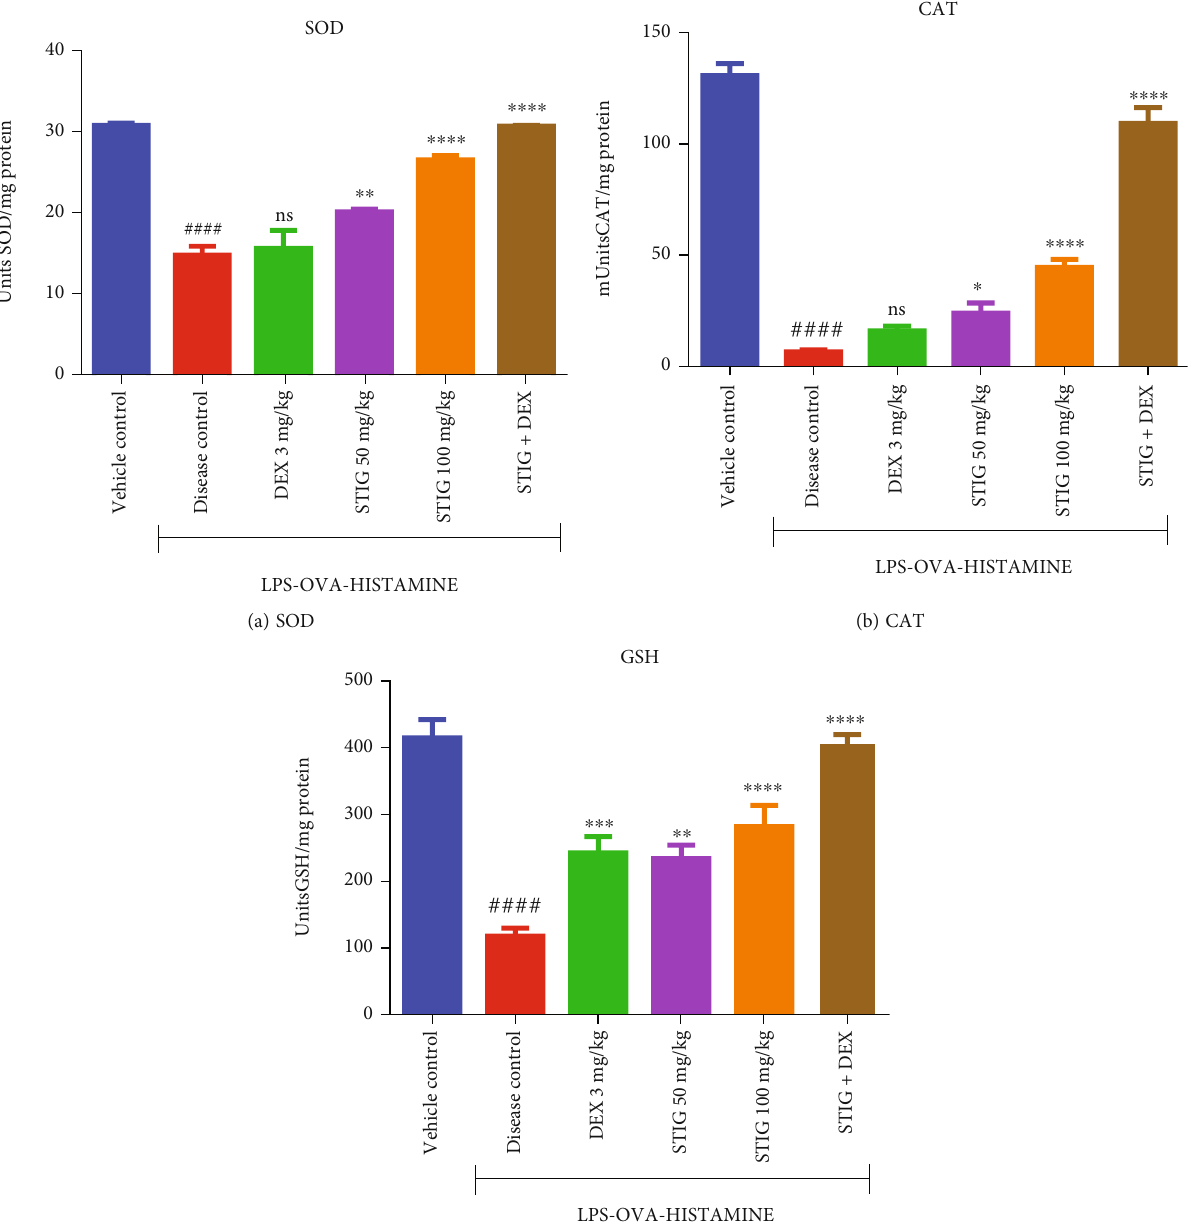
Figure 4: E ff ect of STIG and STIG+DEX on SOD, CAT, and GSH levels. Data is expressed as mean ± SEM . #### p < 0 : 0001 compared to the vehicle control group; ∗∗∗∗ p < 0 : 0001 , ∗∗∗ p < 0 : 001 ∗∗ p < 0 : 01 , ∗ p < 0 : 05 , and ns (not signi fi cant) as compared to the disease control group using one-way ANOVA followed by Dunnett ’ s post hoc test